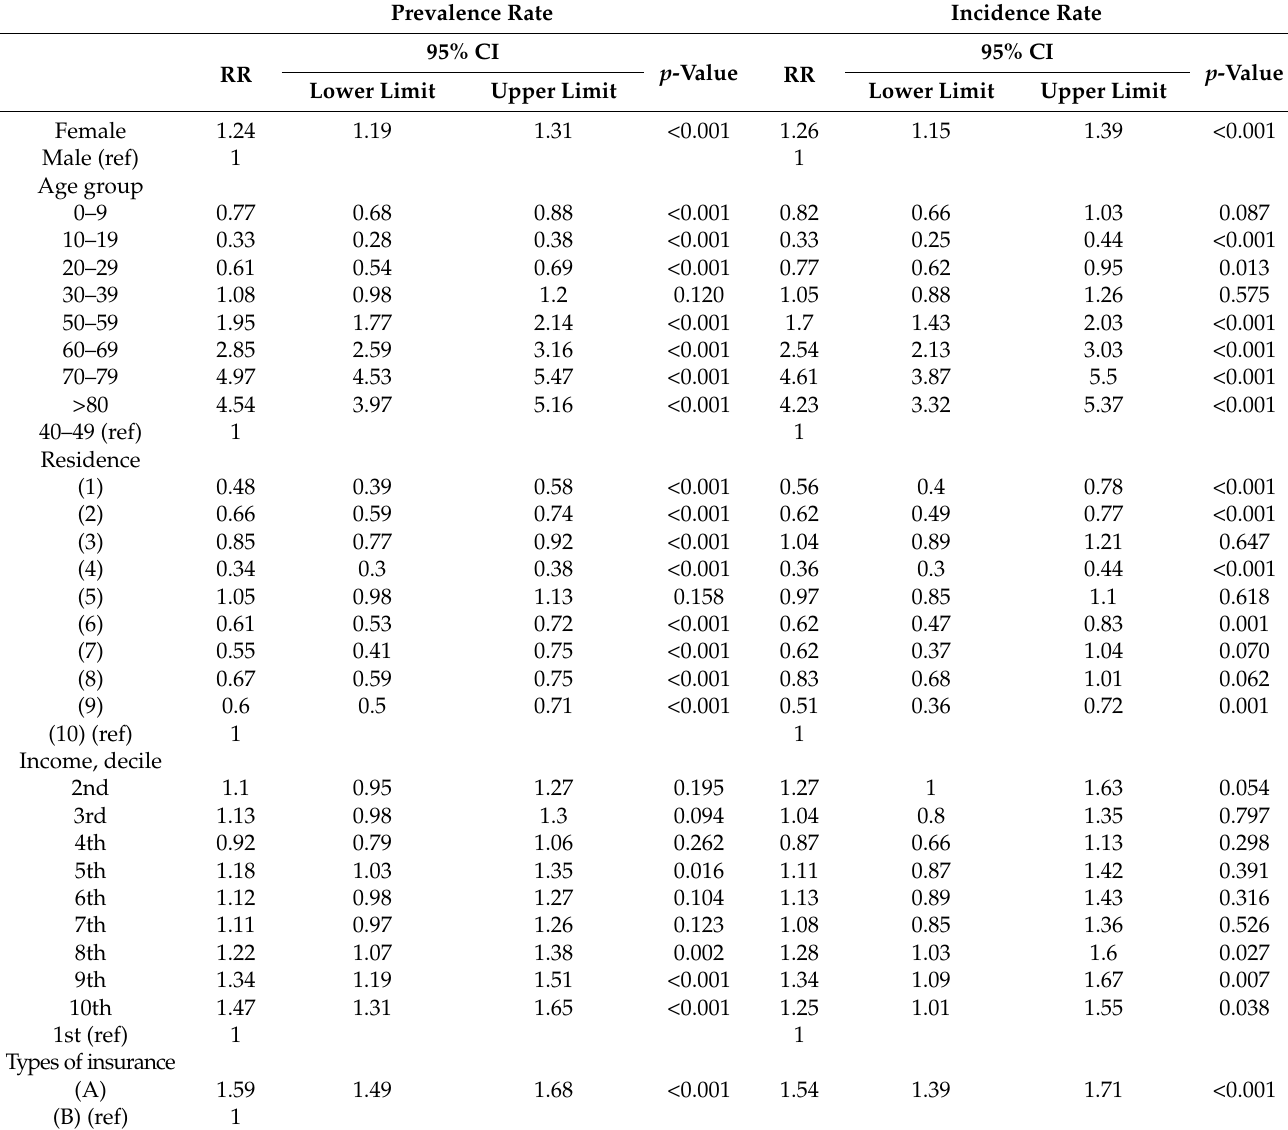
Table 2. Poisson regression to estimate the relative risk of annual prevalence and incidence rate of NTM. Prevalence Rate Incidence